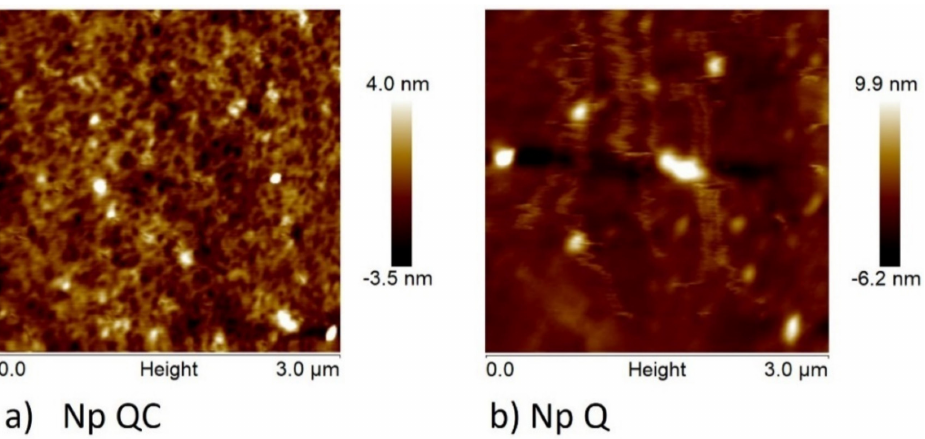
Figure 1. Atomic force microscopy (AFM) image of nanoparticles made of ( a ) capsaicin-loaded chitosan (Np QC) and ( b ) chitosan (Np